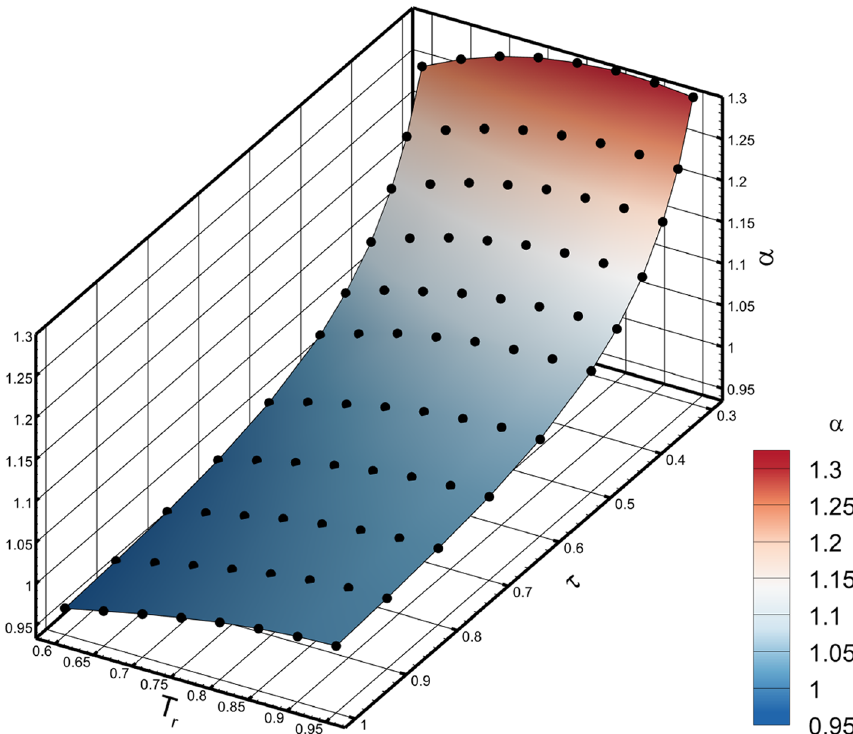
Fig. 7 Variation of isotropy-preserving parameter α with regard to relaxation time τ and reduced temperature T